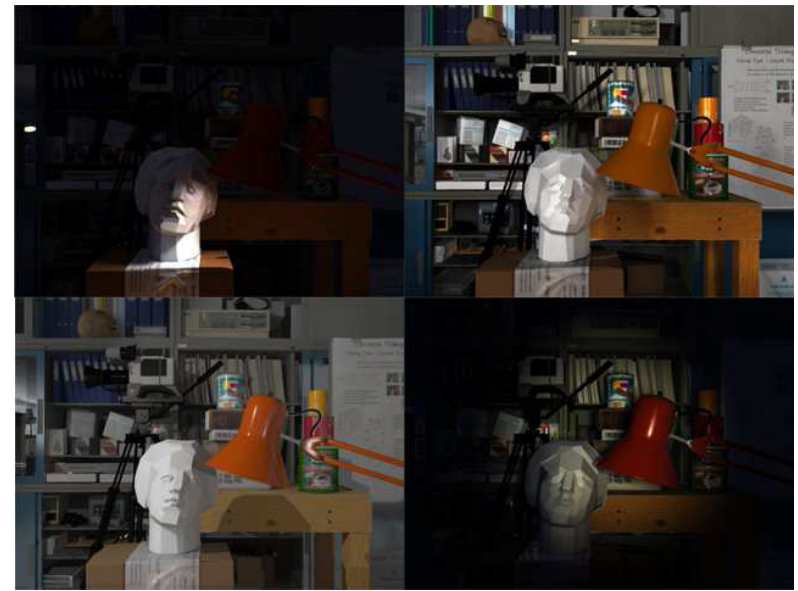
Figure 8. Four illumination conditions: upper-left: lamps; upper-right: fluorescent; lower-left: daylight; lower-right: flashlight.